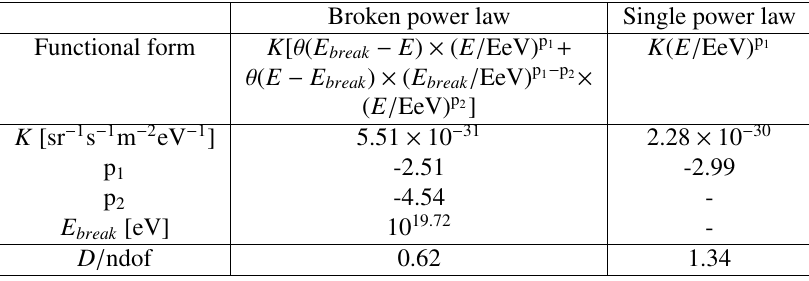
Table 2: The fit functions and fit results shown in Fig5. The deviance D / ndof behaves approximately as χ 2 / ndof of chi-square distribution [14]. θ ( E ) is a step